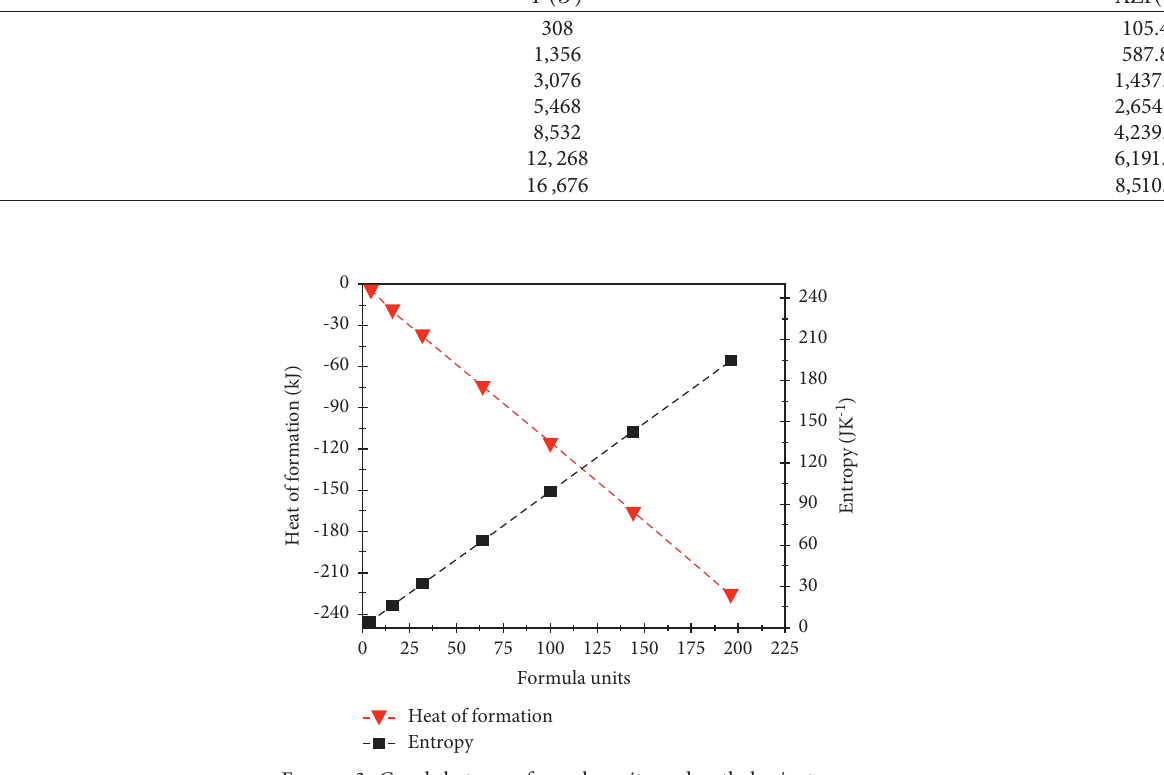
Figure 3: Graph between formula units and